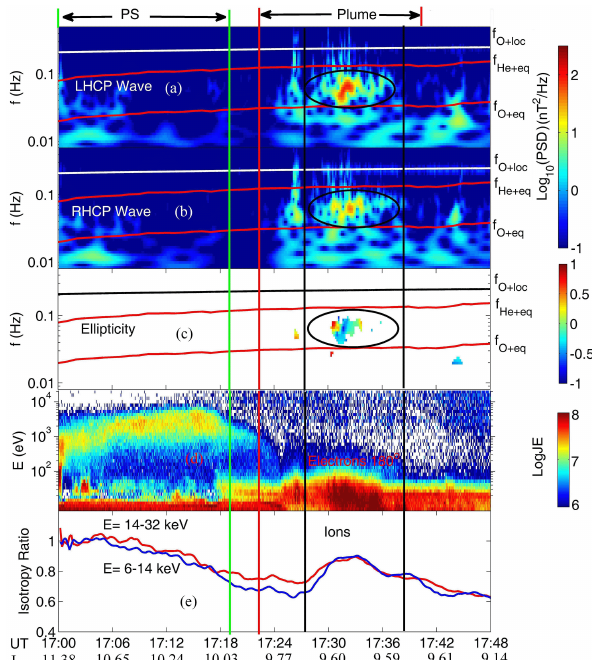
Figure 5. Wavelet power spectrum of the perturbed magnetic field, electron energy–time spectrogram in particle energy flux units (keVcm − 2 s − 1 sr − 1 keV − 1 ) , isotropy ratio of ions with energies of 6–14keV and 14–32keV between 17:00 and 17:48UT on 3 June 2004. Panels (a–c) , from top to bottom, the power spectrum of LHCP, RHCP components and the ellipticity of the transverse waves in the field-aligned coordinates are plotted, respectively. Pe- riods of enhanced EMIC wave power are circled in black. Panel (d) : PEACE electron energy–time spectrogram in particle energy flux units at pitch angles of 180 ◦ . Panel (e) : isotropy ratio of ions with energies of 6–14keV (blue lines) and 14–32keV (red lines) mea- sured by HIA. Two black vertical lines denoted the enhancements of ion isotropy ratio in the outer boundary of the plasmaspheric